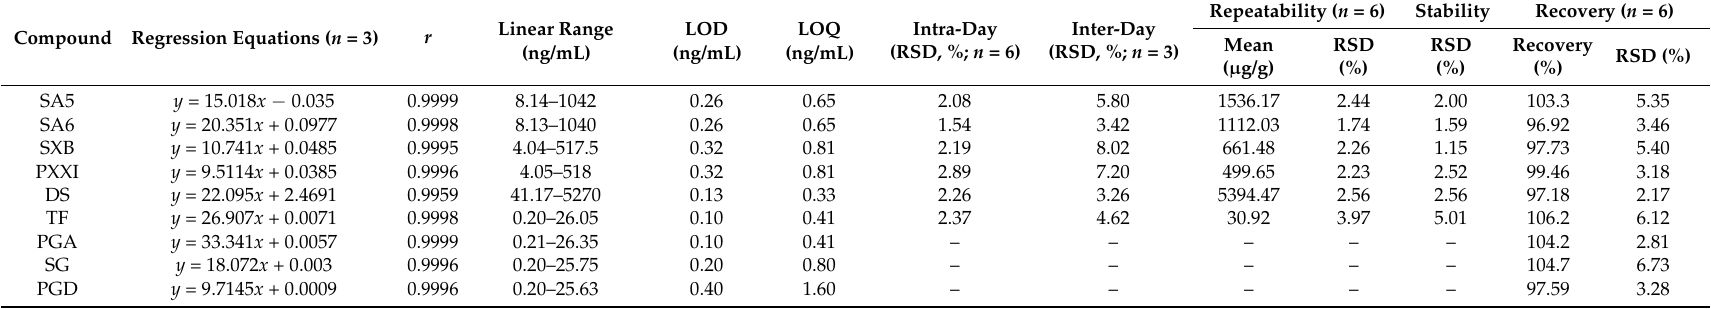
Table 2. Regression equations, LODs, LOQs, intra-day and inter-day precisions, repeatability, stability, and recovery test for the nine detected compounds of RP.